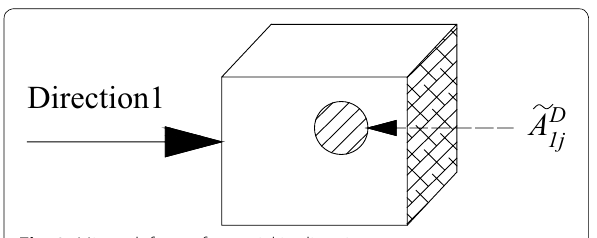
Fig. 2 Micro‑defects of material in direction